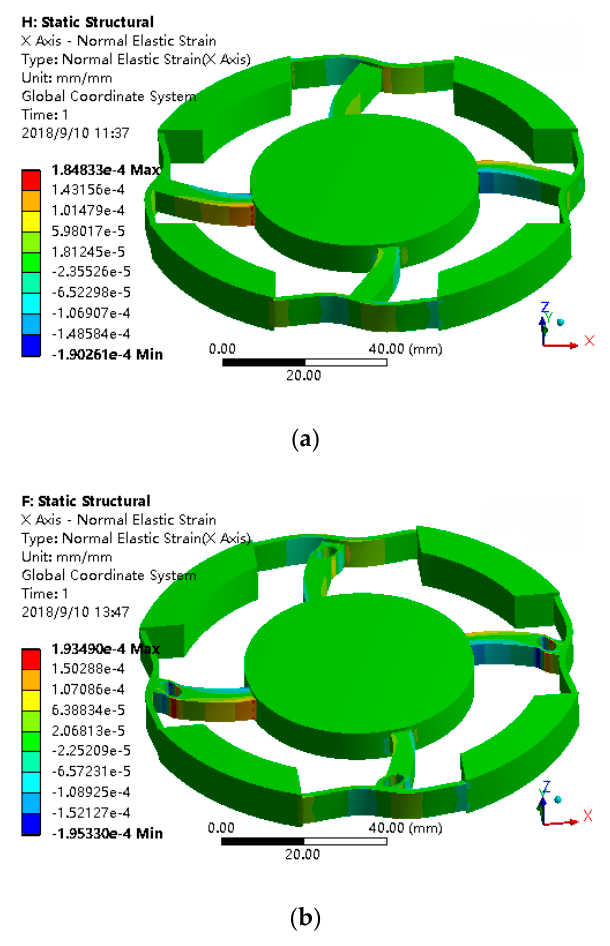
Figure 10. ( a ) The X direction strain without hole under M z = 2.5 Nm. ( b ) The X direction strain with hole under M z = 2.5 Nm.